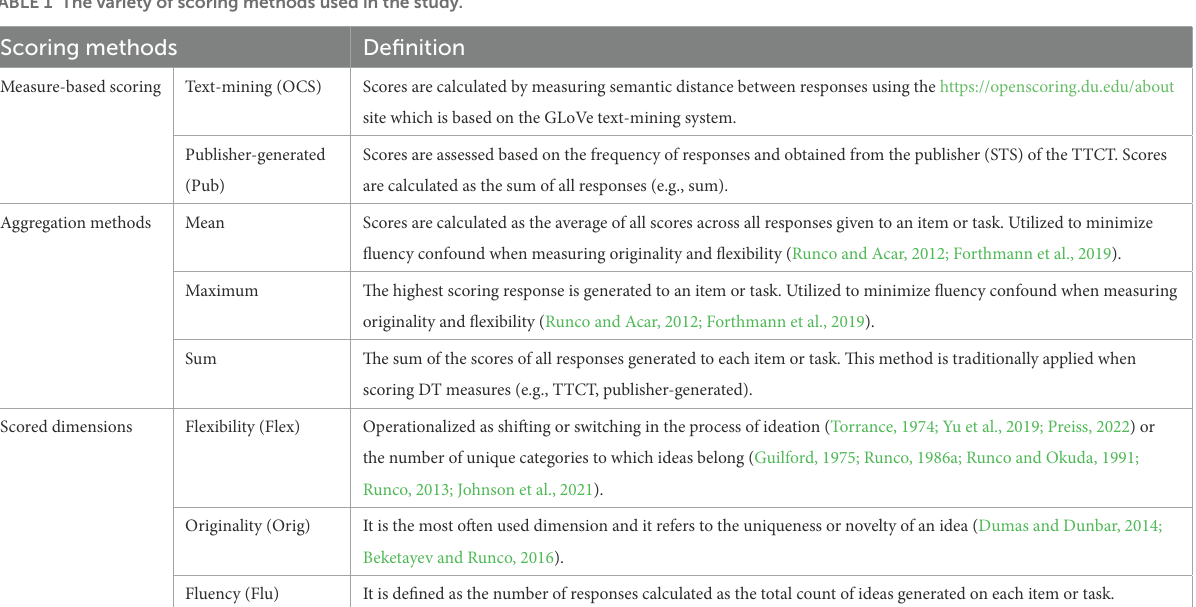
TABLE 1 The variety of scoring methods used in the